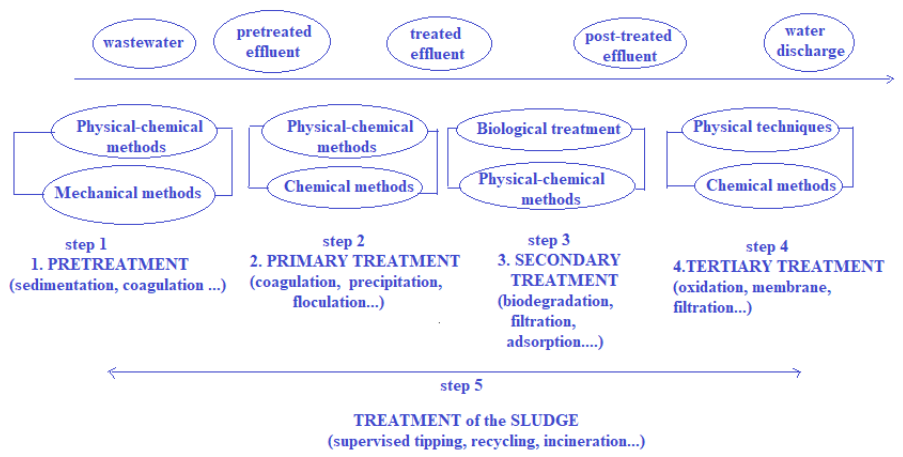
Figure 3. Wastewater treatment methods (adapted from [100]) .